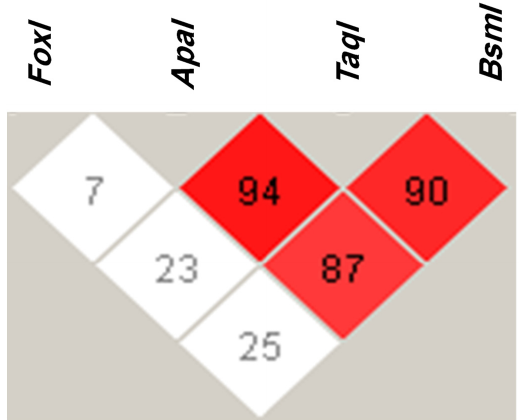
Figure 2. Linkage disequilibrium (LD) of the FokI (rs2228570 C > T), ApaI (rs7975232 A > C), TaqI (rs731236 T > C), and BsmI (rs1544410 C > T) VDR alleles in type 2 diabetes mellitus patients. LD was determined using Haploview software. Red squares represent a strong LD, and white squares a weak LD. The blue square indicates no LD.